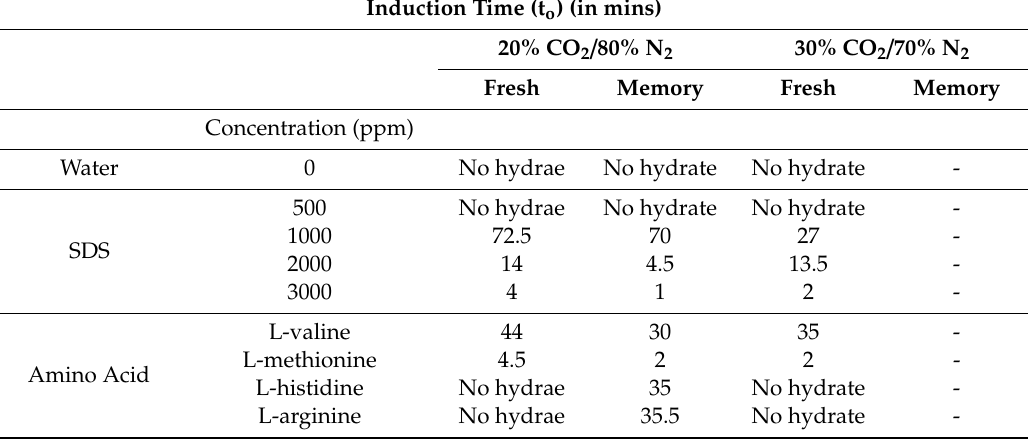
Table 6. E ff ect of CO 2 % on induction time measurement. Induction time is measured for SDS and amino acids during fresh and memory run. Initial pressure and temperature conditions are 120 bar and 1 ◦